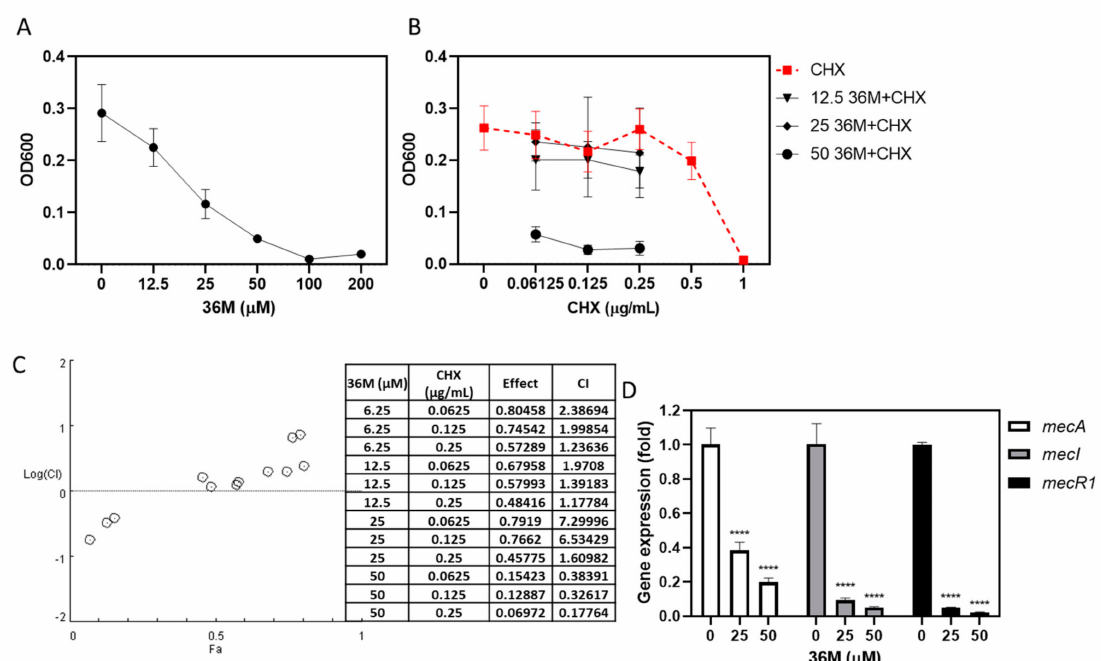
Figure 4. The 36M derivative reduced the resistance of MRSA to CHX. ( A ) The OD600 after MRSA was treated with various doses of 36M for 8 h. ( B ) The OD600 after MRSA was treated with various doses of CHX, and 0.06125–0.25 µ g/mL CHX combined with 12.5-50 µ M 36M for 8 h. ( C ) Logarithmic combination index plot of 36M and CHX co-treatment with the corresponding CompuSyn